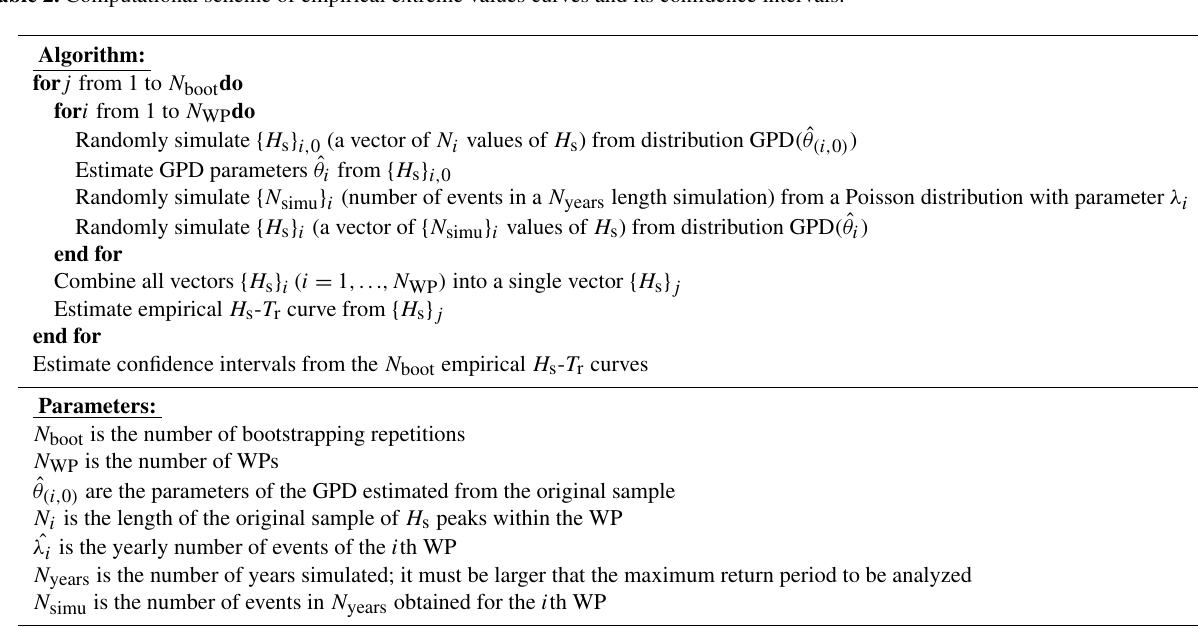
Table 2. Computational scheme of empirical extreme values curves and its confidence